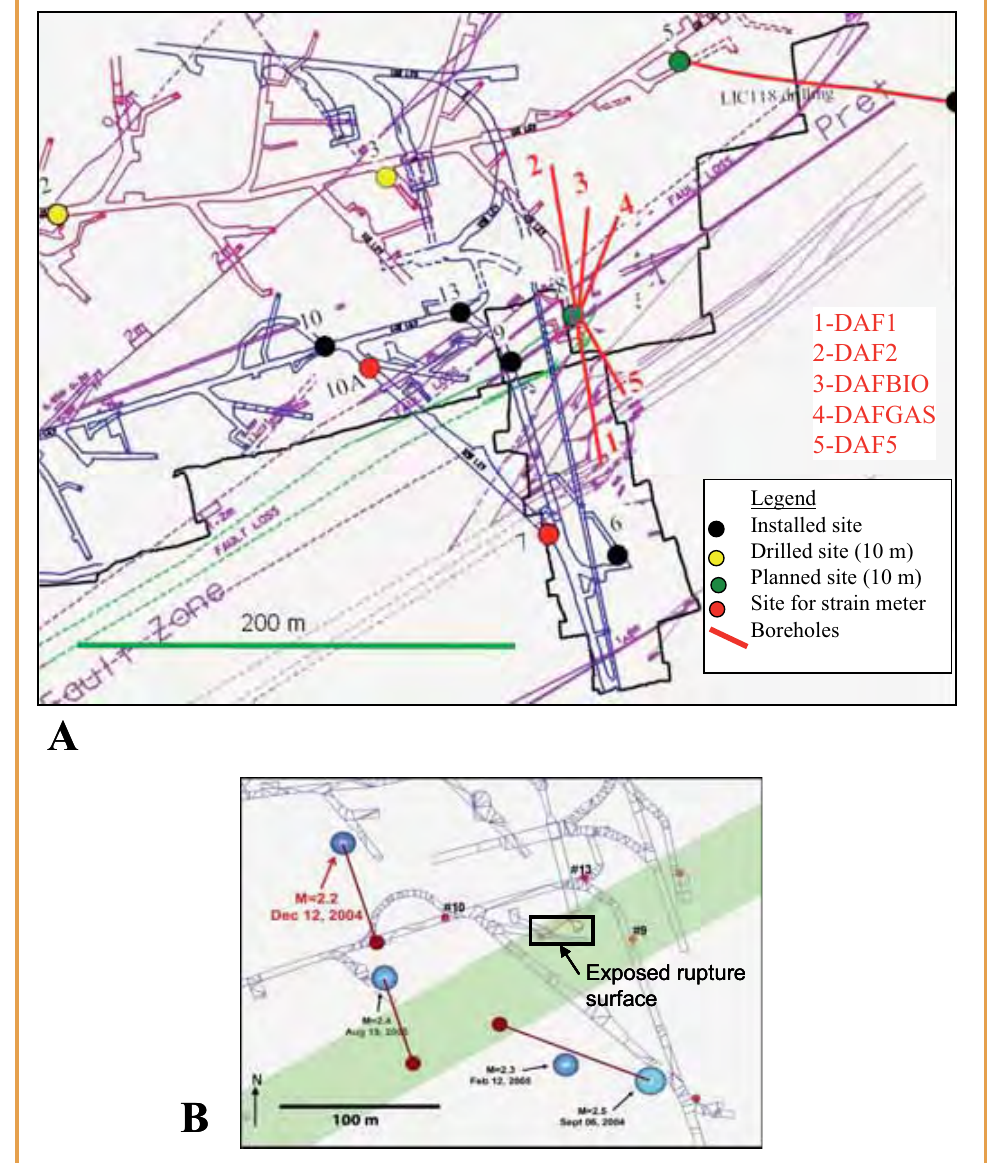
Figure 2. [A] Earthquake laboratory at levels 118–120 of TauTona mine. Tunnels at level 118 (depth = 3.54 km) are marked by red lines; tunnels at level 120 (depth = 3.6 km) are marked by blue lines; wide zone in light green is Pretorius fault zone; thick black line marks margins of mining on both sides of Pretorius fault. Note that while only a small part south of fault has been mined, this part will be mined in next decade; sites marked 2–10 indicate sites of installed or planned system of two 3-D accelerometers, EM sensors and ther- mistors; Site 8 is laboratory cubby with fi ve inclined boreholes (Fig. 3). [B] Locations of m > 2 events near the laboratory. Original locations marked in light blue circles; preliminary relocations are marked by brown solid circles connected to original location. Note that relocation moves events closer to Pretorius